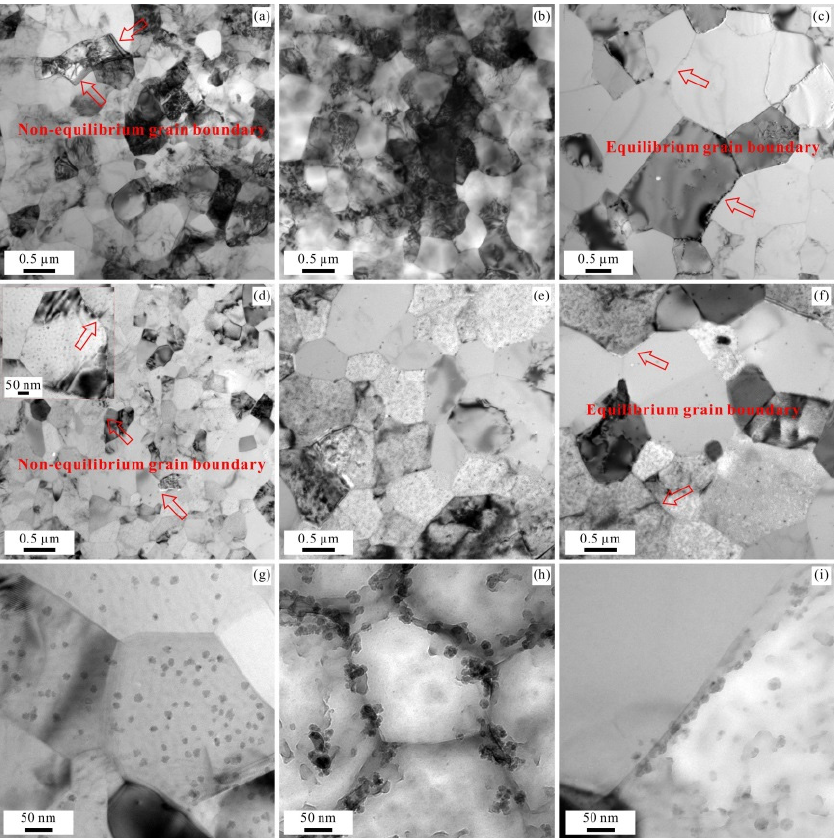
Figure 3. The radial microstructures observed by TEM of ( a ) the cold-drawn CPAW, ( b ) the CPAW annealed at 90 °C for 8 h, ( c ) the CPAW annealed at 250 °C for 8 h, ( d , g ) the cold-drawn AFW, ( e , h ) the AFW annealed at 200 °C for 8 h, ( f , i ) the AFW annealed at 250 °C for 8 h.